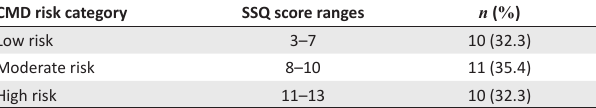
TABLE 3: Shona Symptom Questionnaire (SSQ) total CMD scores for participants ( n = 31).